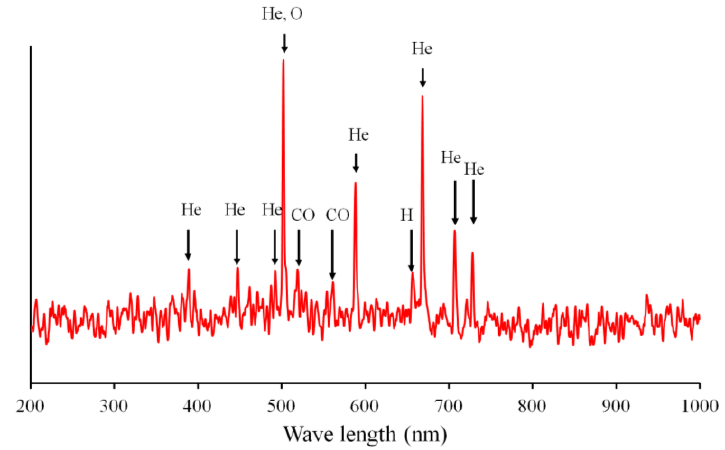
Figure 2. Optical emission spectrometer (OES) of the plasma for synthesizing the PEO-like polymer.